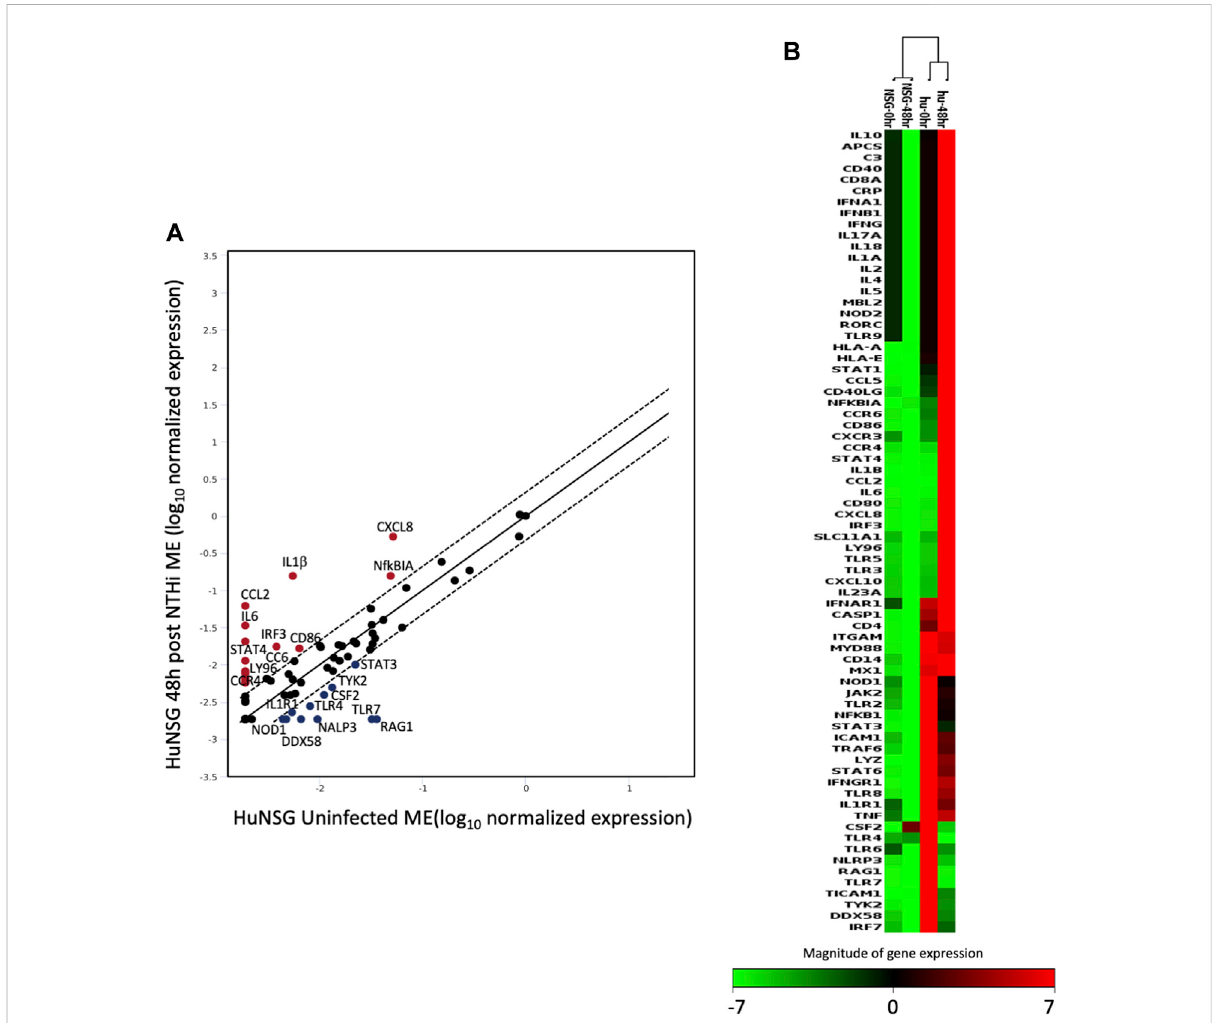
FIGURE 6 The expressionchange of 84 human genes related to in fl ammatory pathwaysinhumanized mice after NTHi inoculation was evaluated by real- time PCR based array analysis (Qiagen). (A) Scatter Plot representing the expression level of each human gene in huNSG ME at 48 h post NTHi infection vs. uninfected huNSG (0 h). Genes above and below the red lines are regulated more than two-fold (up or down) in 48 h infected vs. 0 h samples ( n = 3). (B) Non-supervised hierarchical clustering of the entire dataset (huNSG at 0 h and 48 h plus unengrafted NSG controls at 0 h and 48 h) providing an overview of gene expressionpatters as a continuous heat-map based on magnitude of gene expression. Red represents high expression, while green represents low expression and black is no change. NSG control data ( fi rst two columns) have low to no expression (green/ black color) indicating that the array probes did not cross-react with mouse RNA. The rows represent genes evaluated by the Qiagen RT2